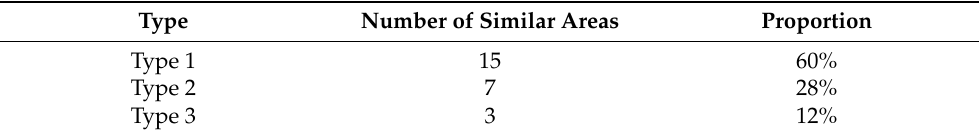
Figure 6. Spatial relationship of online car-hailing demand. Table 1. K-means clustering results of similar regions.